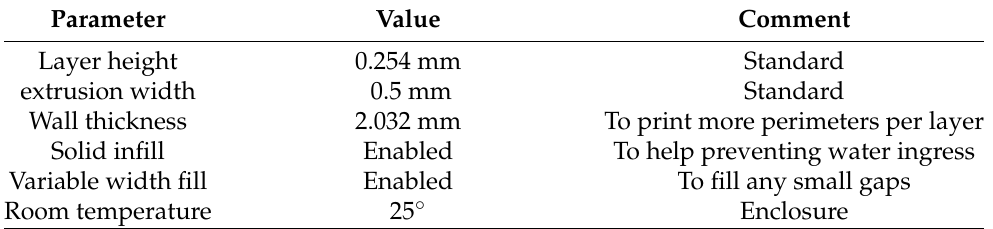
Table 2. List of the 3D Printer Parameters.